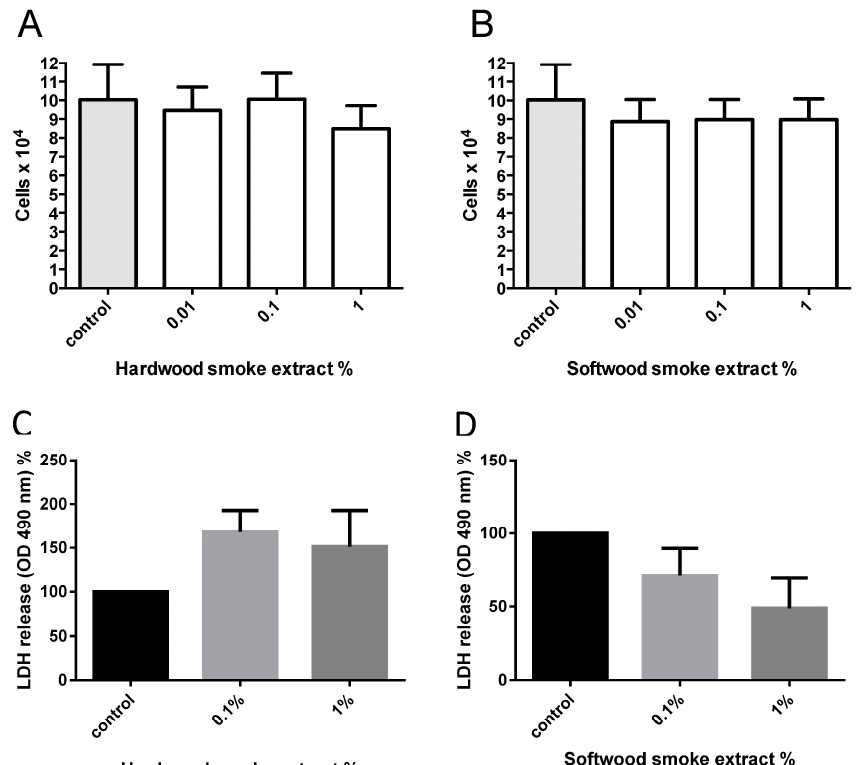
Figure 2. Measurement of cell viability from hardwood ( A , C ) and softwood ( B , D ) smoke extract stimulation at lower concentrations. Cell viability was measured via Manual cell count with trypan blue (0.02% w / v ) and LDH assay from hardwood and softwood smoke extract stimulation at 0.01%, 0.1%, and 1% diluted in 0.1% FBS/DMEM in primary human lung fibroblasts ( n = 6). Manual cell count and LDH assay was executed after 24 h post-stimulation. Data is expressed in cells/mL ( A , B ), percent of LDH release from control ( C , D ), and bars represent mean ± SEM. Comparison between cell counts from control and different concentrations of hardwood and softwood smoke extract stimulation made by one-way ANOVA with Tukey’s post-test. No significant differences were found.